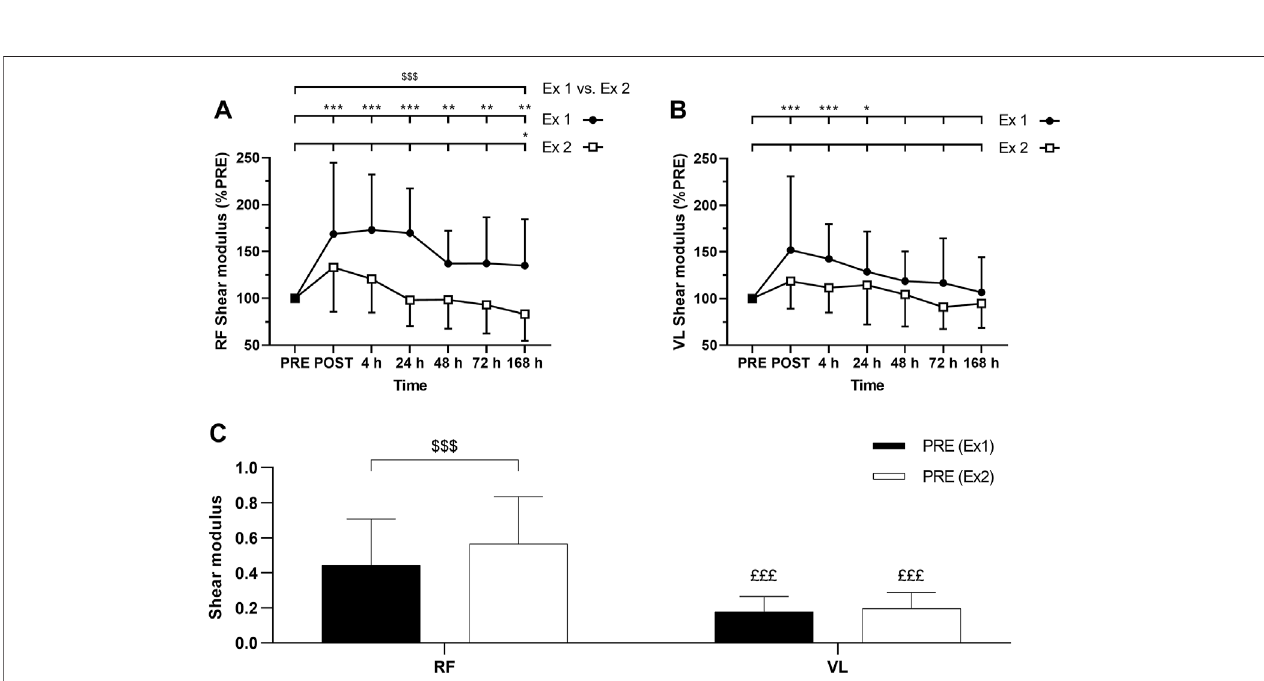
FIGURE 6 | Time course of (A) rectus femoris (RF) and (B) vastus lateralis (VL) shear modulus expressed in percentage of PRE value for exercise 1 and 2, and (C) absolutevaluesofRFandVLshearmodulus(slope) atPREforexercise1andexercise2.Ex:Exercise.*,**and***correspondtosigni fi cantdifferencefromPREvalueat p < 0.05, p < 0.01and p < 0.001,respectively.$$$:signi fi cantdifferencebetweenexercise1andexercise2 at p < 0.001,£££:signi fi cantlydifferentfromRFvalueat p < 0.001.